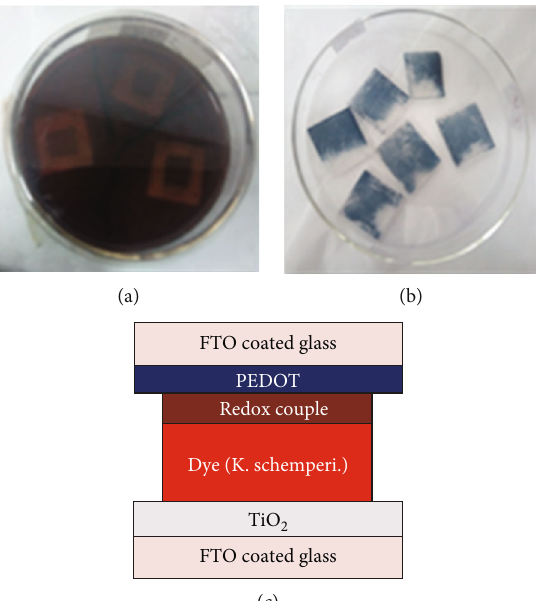
Figure 3: Pictures are showing (a) TiO -coated electrodes soaked into extracts of K. schemperi , (b) PEDOT-coated counter electrode, and (c) 2 completed device structure of fabricated